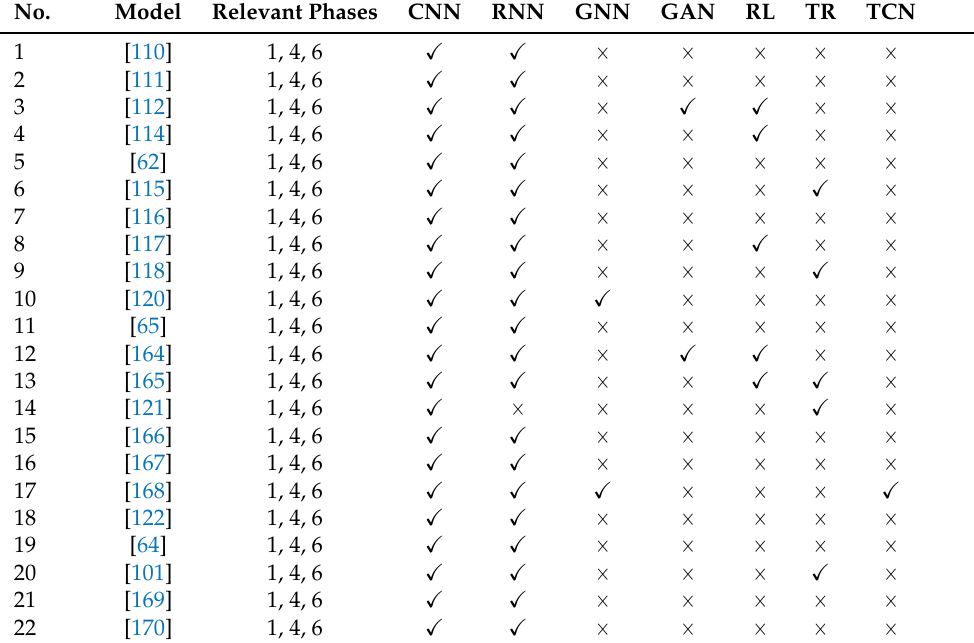
Table 4. Storytelling with Image Data Models. The check marks demonstrate that the model employs and supports the corresponding module and the cross marks depict the opposite of this